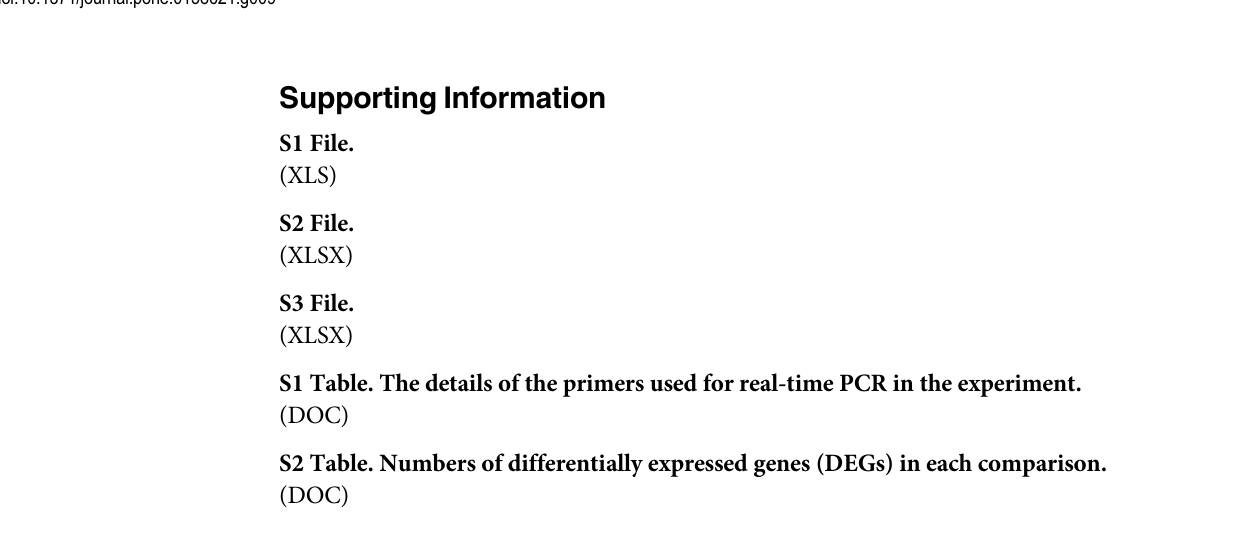
S2 Table. Numbers of differentially expressed genes (DEGs) in each comparison.